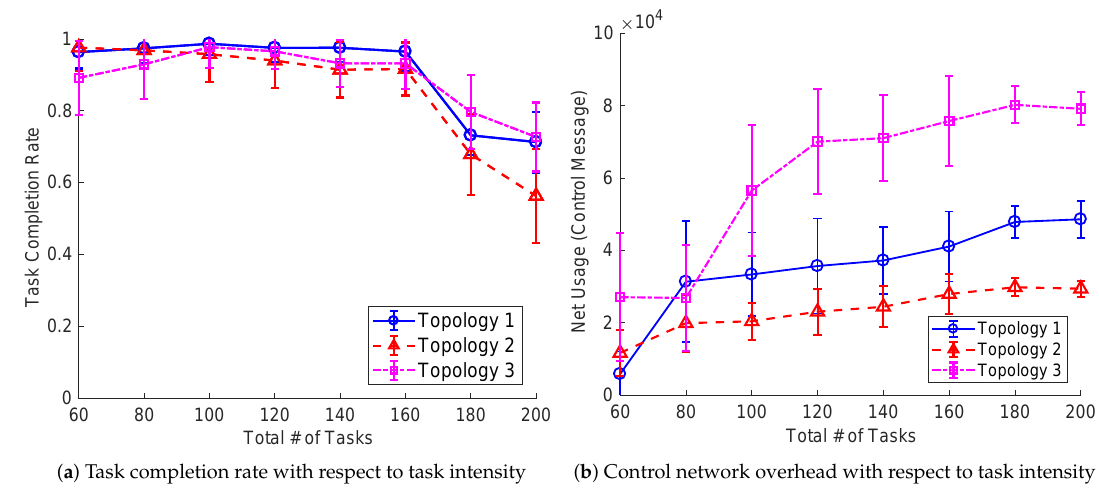
Figure 12. Performance in three different node topologies with respect to task intensity.